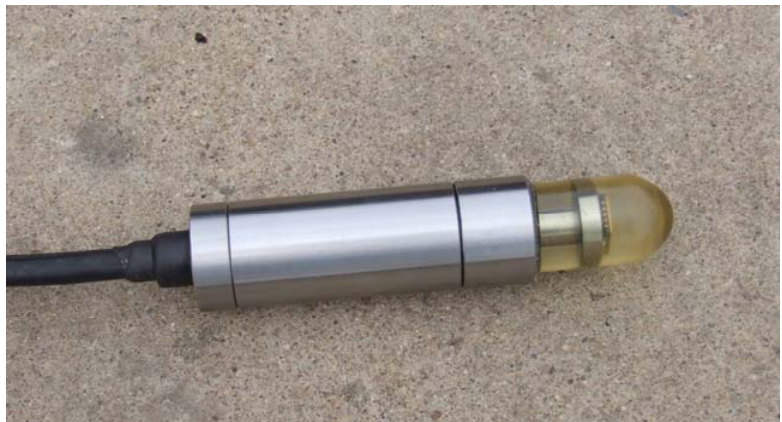
Figure 9. The photo of the MEMS vector hydrophone.